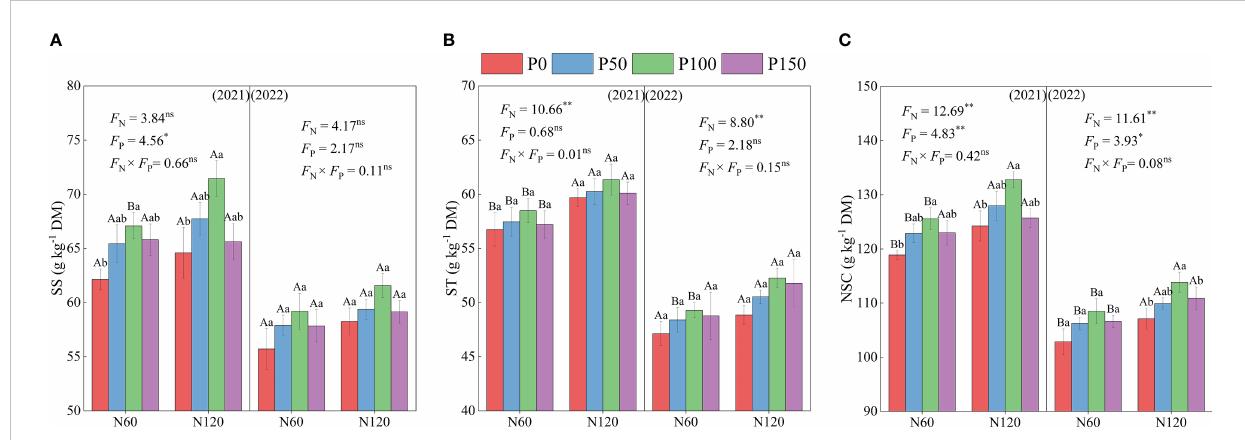
FIGURE 3 SS, soluble sugar (A) , ST, starch (B) and NSC, non-structural carbohydrate (C) of alfalfa during difference nitrogen and phosphorus combined fertilization in 2021 to 2022. Different small letters indicate signi fi cant differences between different P fertilizer treatments under the same N application condition ( p < 0.05). Different capital letters indicate signi fi cant differences between different N fertilizer levels under the same P application condition ( p < 0.05). F N , F P and F N × F P represent the F value under the N application levels, P application levels and the interaction of N and P application levels, respectively. ns indicates no signi fi cant difference ( p > 0.05), * indicates signi fi cant difference ( p < 0.05) and ** indicates extremely signi fi cant difference ( p < 0.01).